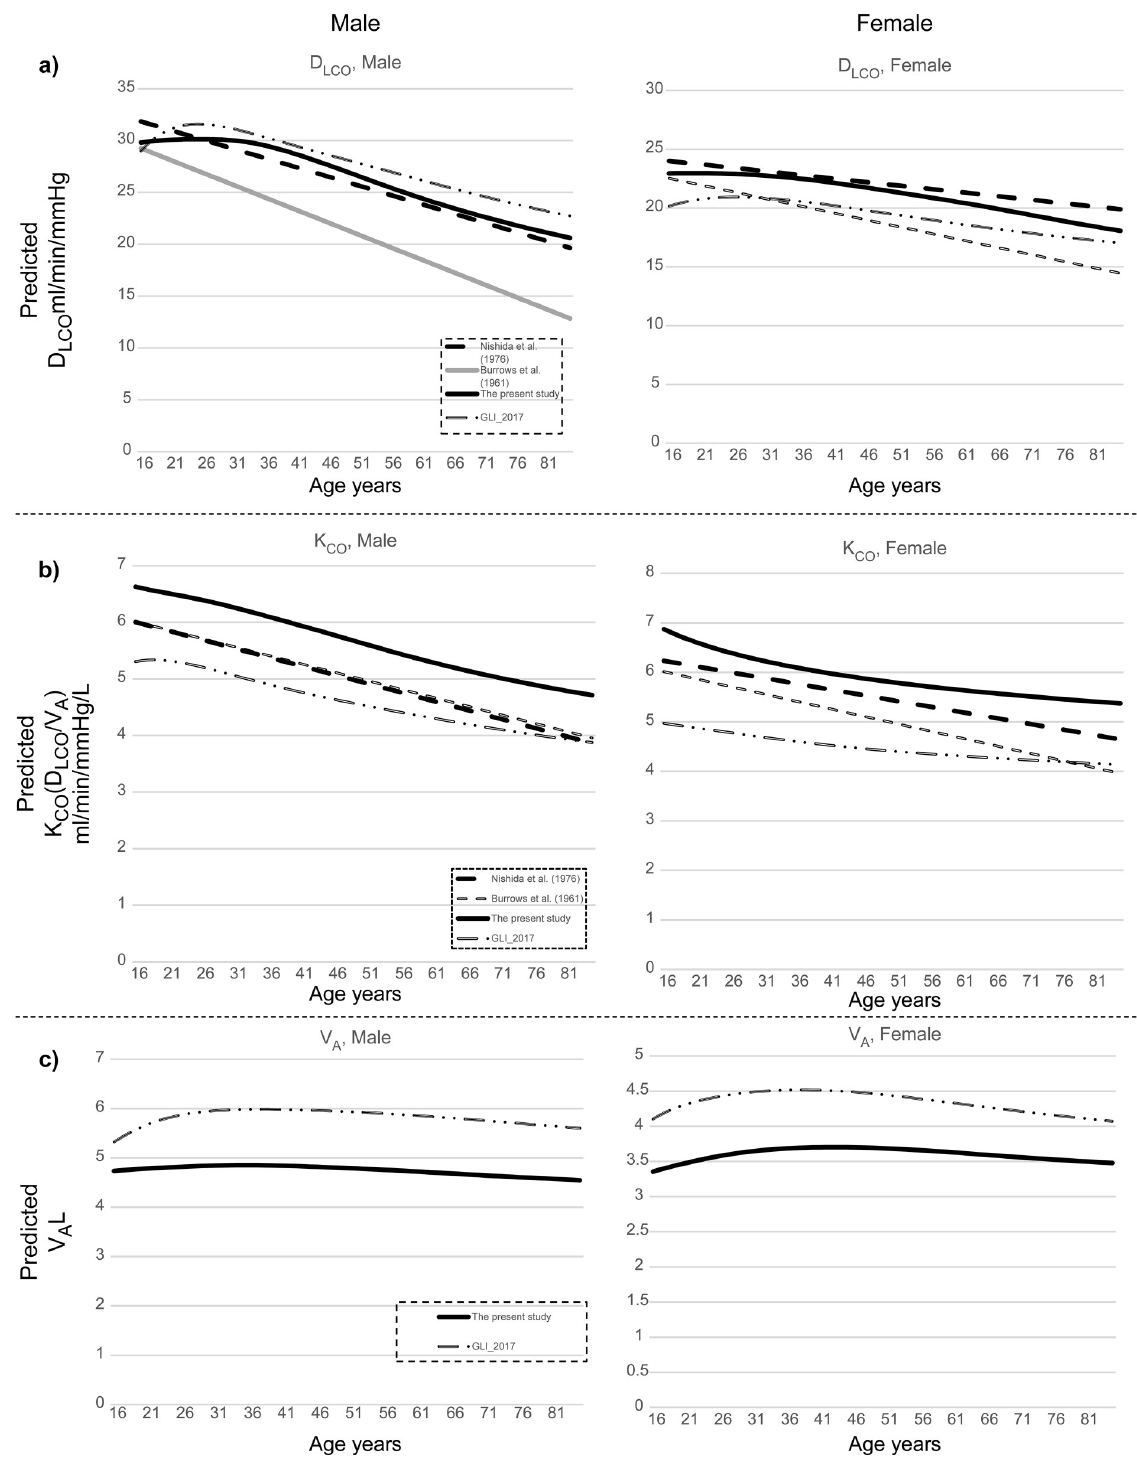
Fig 4. Comparison of reference equations in men. Predicted a) single breath diffusing capacity for carbon monoxide (D LCO ), b) single breath diffusing capacity for carbon monoxide per unit of lung volume (D LCO /V A ), and c) alveolar volume (V A ). Abbreviations: D LCO , single breath diffusing capacity for carbon monoxide; K CO , single breath diffusing capacity for carbon monoxide per unit of lung volume; and V A , alveolar volume.